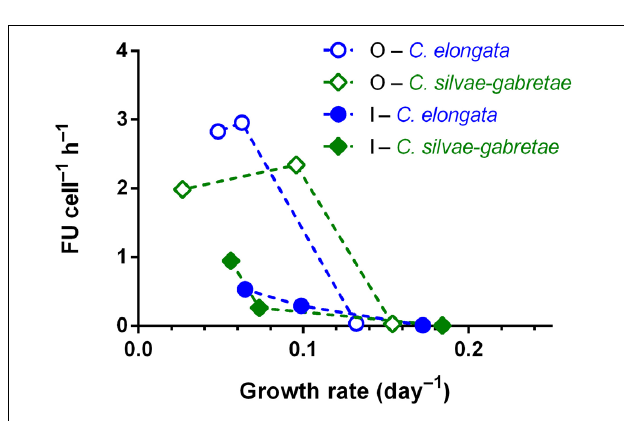
FIGURE 7 | Relationship of cell-specific phosphatase activity (in relative FUs) to the growth rates of Coccomyxa cultures grown with inorganic (I) or organic (O) P source. Symbols are means of